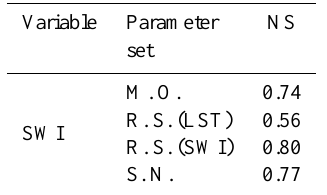
Table 8. The Orba basin. Values of NS on SWI series obtained with the different parameter sets. The basin scale mean has been consid- ered.